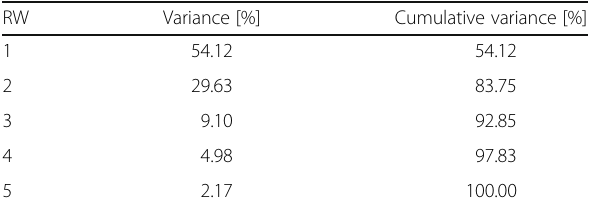
Table 2 Percentage of total variance explained and cumulative variance per relative warp (RW)